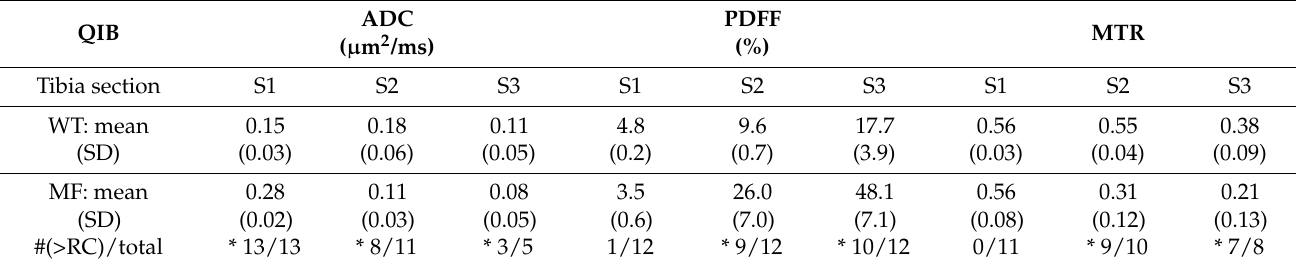
Table 2. Mean QIB values for WT mice and 5–6 weeks post-ablation for MF mice.